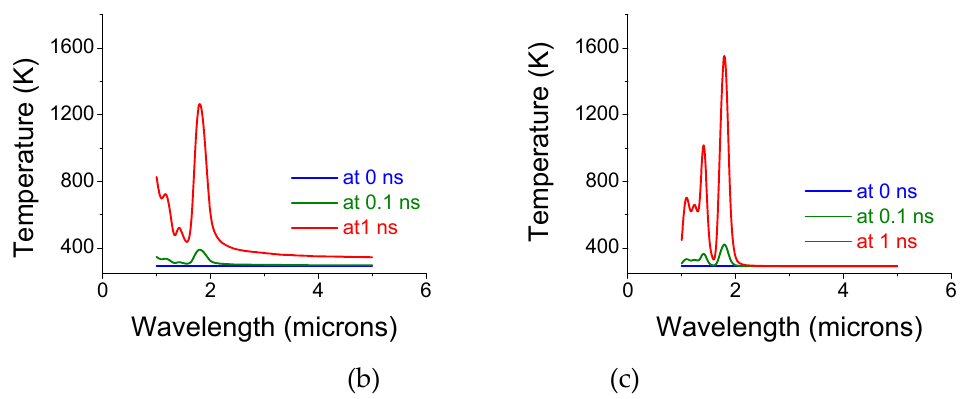
Figure 8. ( a ) Temperature distribution in Kelvins ( o K) after 1 ns at peak electromagnetic absorption wavelength ( λ ~1.8 microns) when the gap is filled with polyimide/silica spheres (n polyimide = 1.7/ n silica = 1.45). ( b ) Average temperature at the top screen as a function of wavelength at 0, 0.1, and 1 ns of exposure. ( c ) Average temperature at the bottom (back) copper disks.